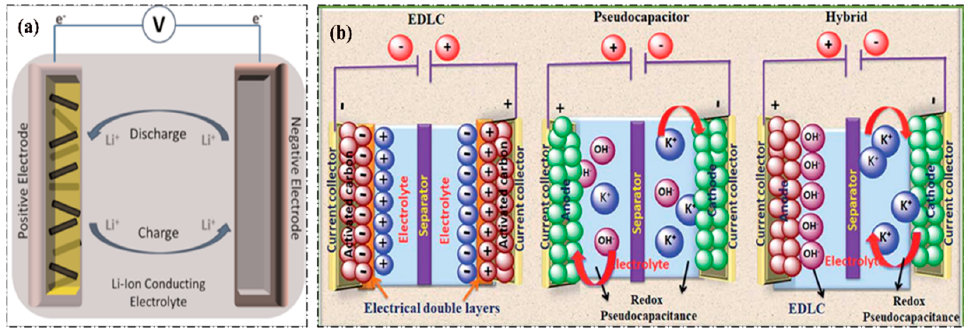
Figure 1. The charge storage mechanism of ( a ) Li-ion batteries (LIBs) and ( b ) different types of supercapacitors (SCs), ( a ) Reprinted with permission from Ref. [23]. Copyright 2017 American Chemical Society; ( b ) Reprinted with permission from Ref. [24]. Copyright 2019 The Royal Society of Chemistry.